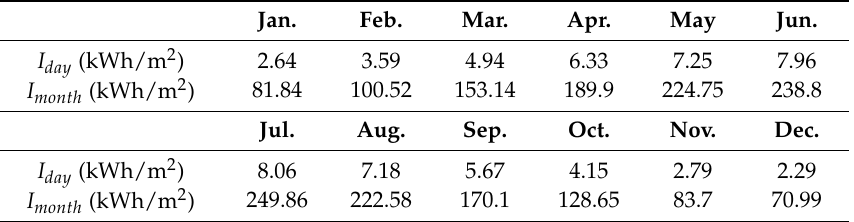
Table 2. Daily and monthly solar radiation in Malta (average values 2000–2010).